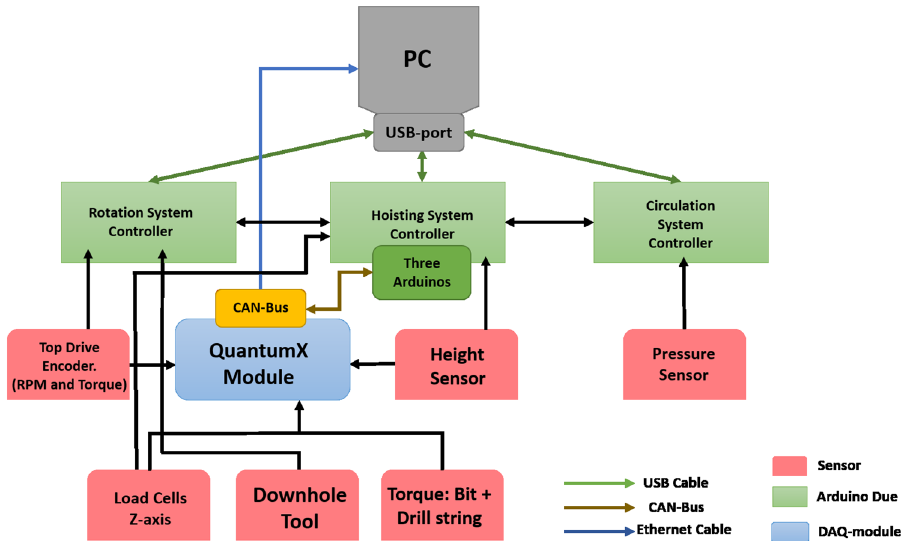
Fig. 4 Overview of the control system